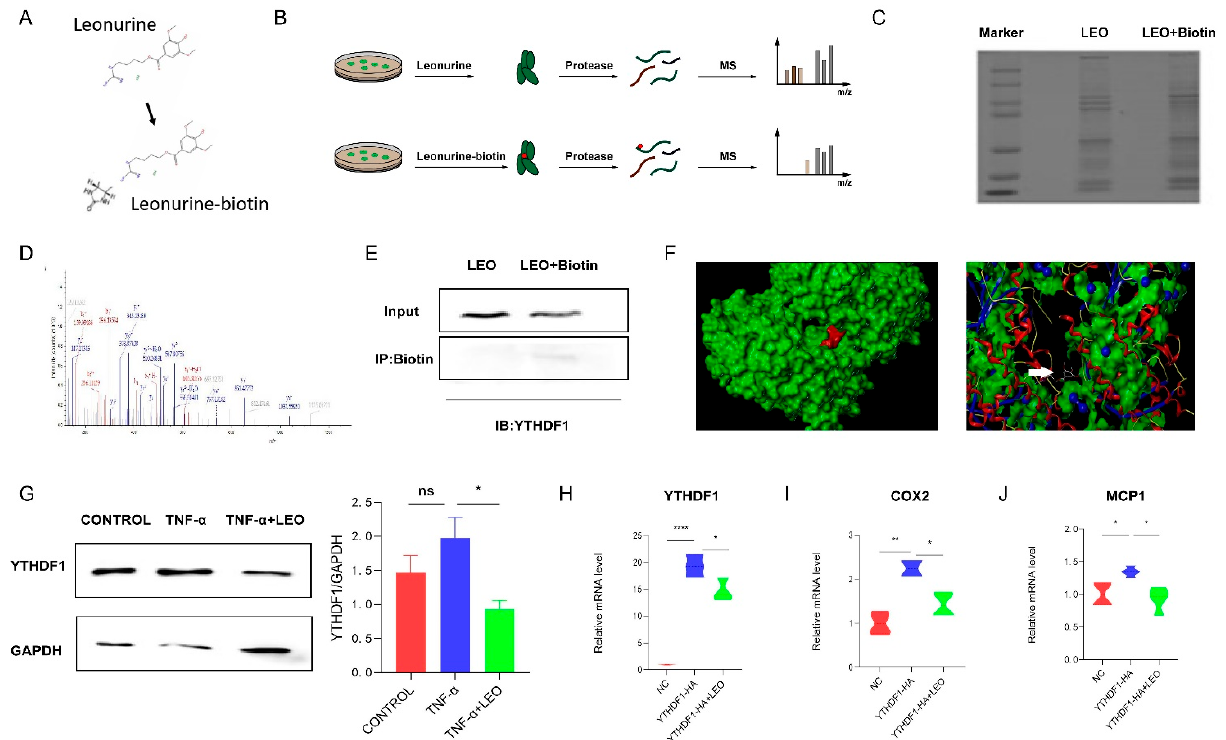
Figure 5. LEO targets YTHDF1 protein. ( A ) The chemical constructions of LEO and the biotin-conjugated LEO. ( B ) Flowchart of LIP-MS analysis. Cells were incubated with LEO or biotin-conjugated LEO for 6 h. Then, proteins pulled down by streptavidin beads were used for LC-MS analysis. ( C ) The image of proteins pulled down by streptavidin beads by using sodium dodecyl sulfate polyacrylamide gel electrophoresis. ( D ) Mass spectrum peak of YTHDF1 by LC-MS analysis. ( E ) RAW264.7 cells were incubated with LEO-biotin or LEO, followed by pull-down assay by using streptavidin beads; representative blot from three independent experiments is shown. ( F ) Representative images of autodocking for LEO and YTHDF1. ( G ) The protein level of YTHDF1 and GAPDH were detected by western blot in cell lysates of TNF- α (100 ng/mL)-stimulated RAW264.7 cells, which were pretreated with or without LEO. Image J was used to analyze gray value. Representative blot from three independent experiments is shown. ( H ) RAW264.7 cells were transfected to express YTHDF1-HA and mRNA expression levels of YTHDF1 were measured by qPCR. ( I , J ) RAW264.7 cells were transfected to express YTHDF1-HA and mRNA expression level of COX2 and MCP-1 was measured by qPCR. Data are shown as means ± S.E.M. * p < 0.05, ** p < 0.01 and **** p < 0.0001 between groups.